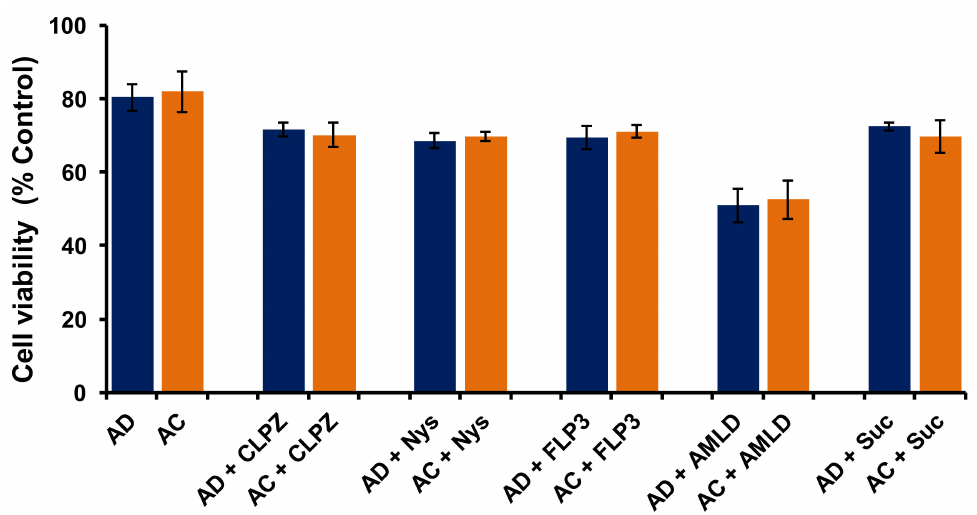
Figure 5. Cell viabilities of SK-Hep1 cells following transfection with AD and AC liposomes in the presence and absence of endocytosis